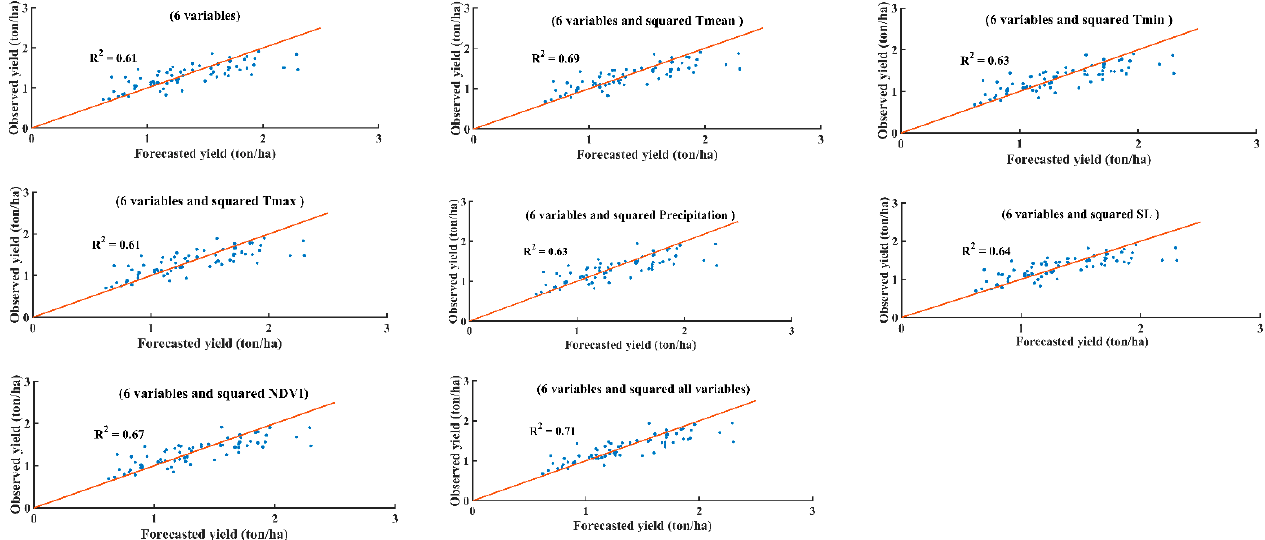
Figure 7. Predict yield of tea by SVM model with 6 variable input or 6 variables and squared one of the variable in order to: Tmean, Tmin, Tmax, Precipitation, Solar radiation, NDVI and all variables.